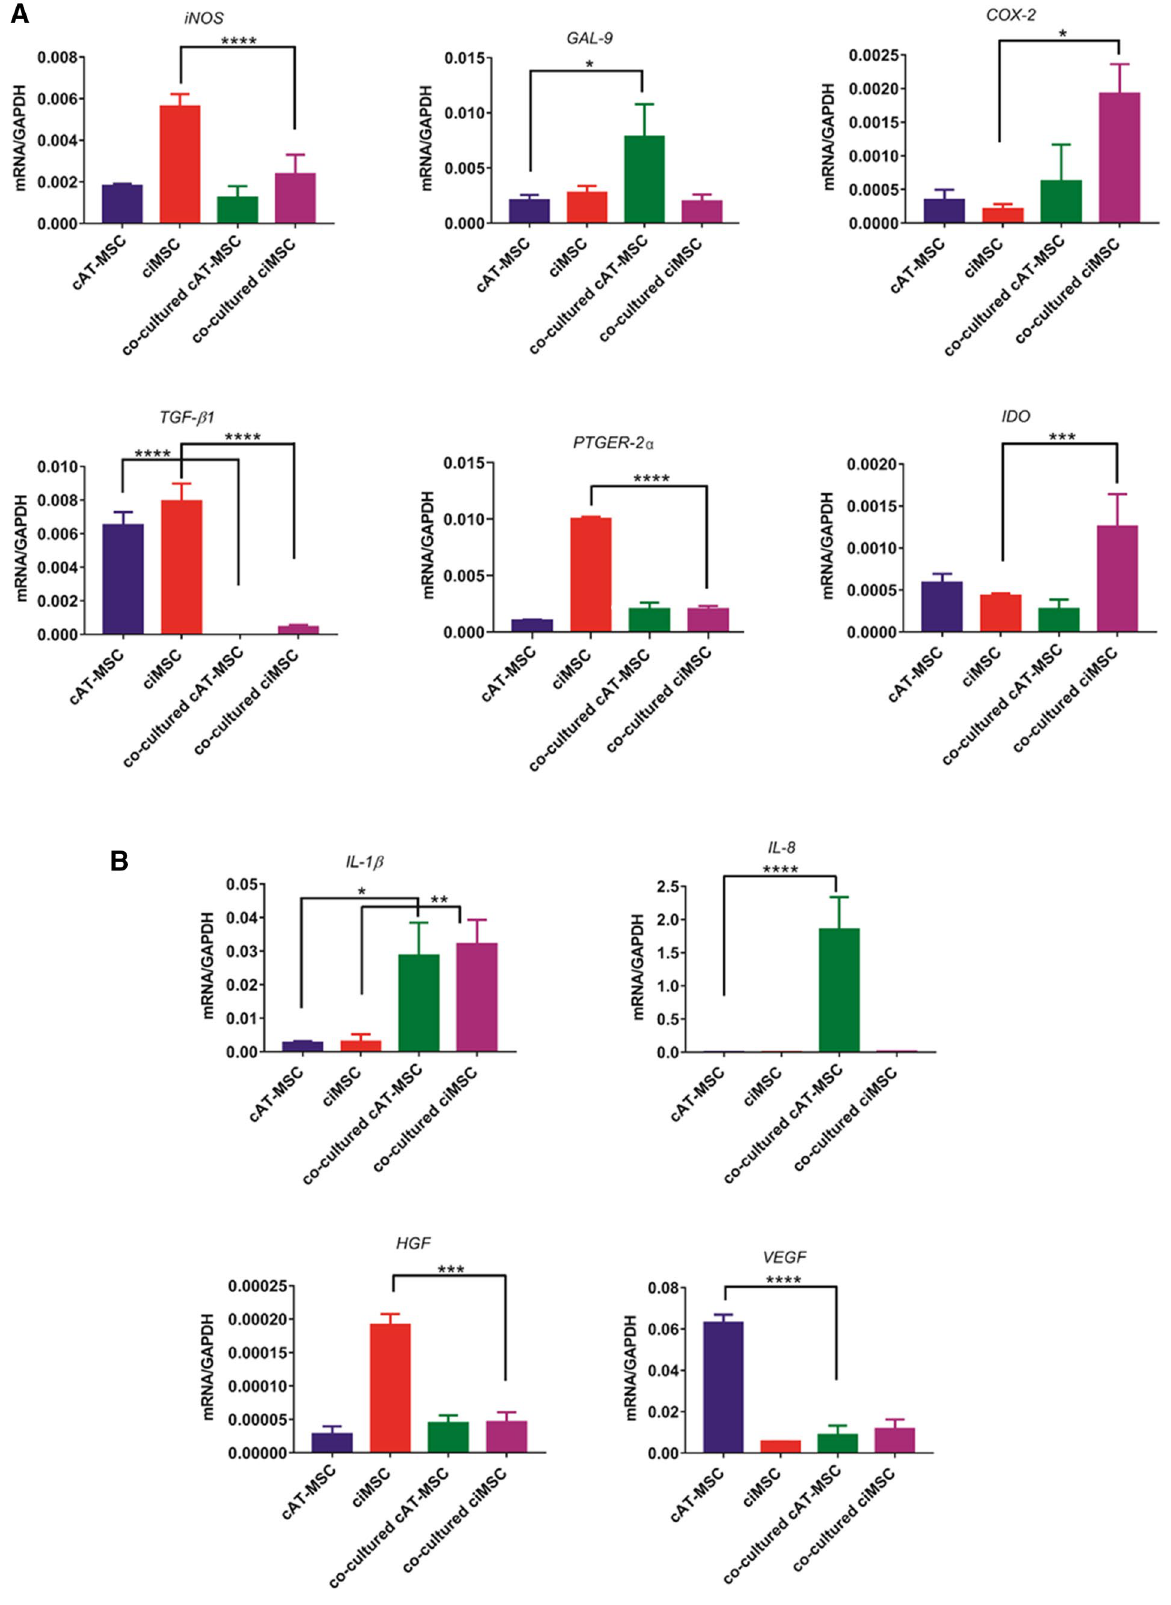
Figure 4. Effect of mitogen-stimulated canine lymphocytes on inflammatory cytokine expression of ciMSCs and cAT-MSCs. When co-cultured with mitogen-stimulated lymphocytes, ciMSCs downregulated their expression of iNOS , HGF , TGF-β1 and PTGER-2α, while increasing their expression of COX-2, IDO and IL-1β . Significance is defined as: ns = not significant p > 0.05; * p ≤ 0.05; ** p ≤ 0.005; *** p ≤ 0.0002; **** p ≤